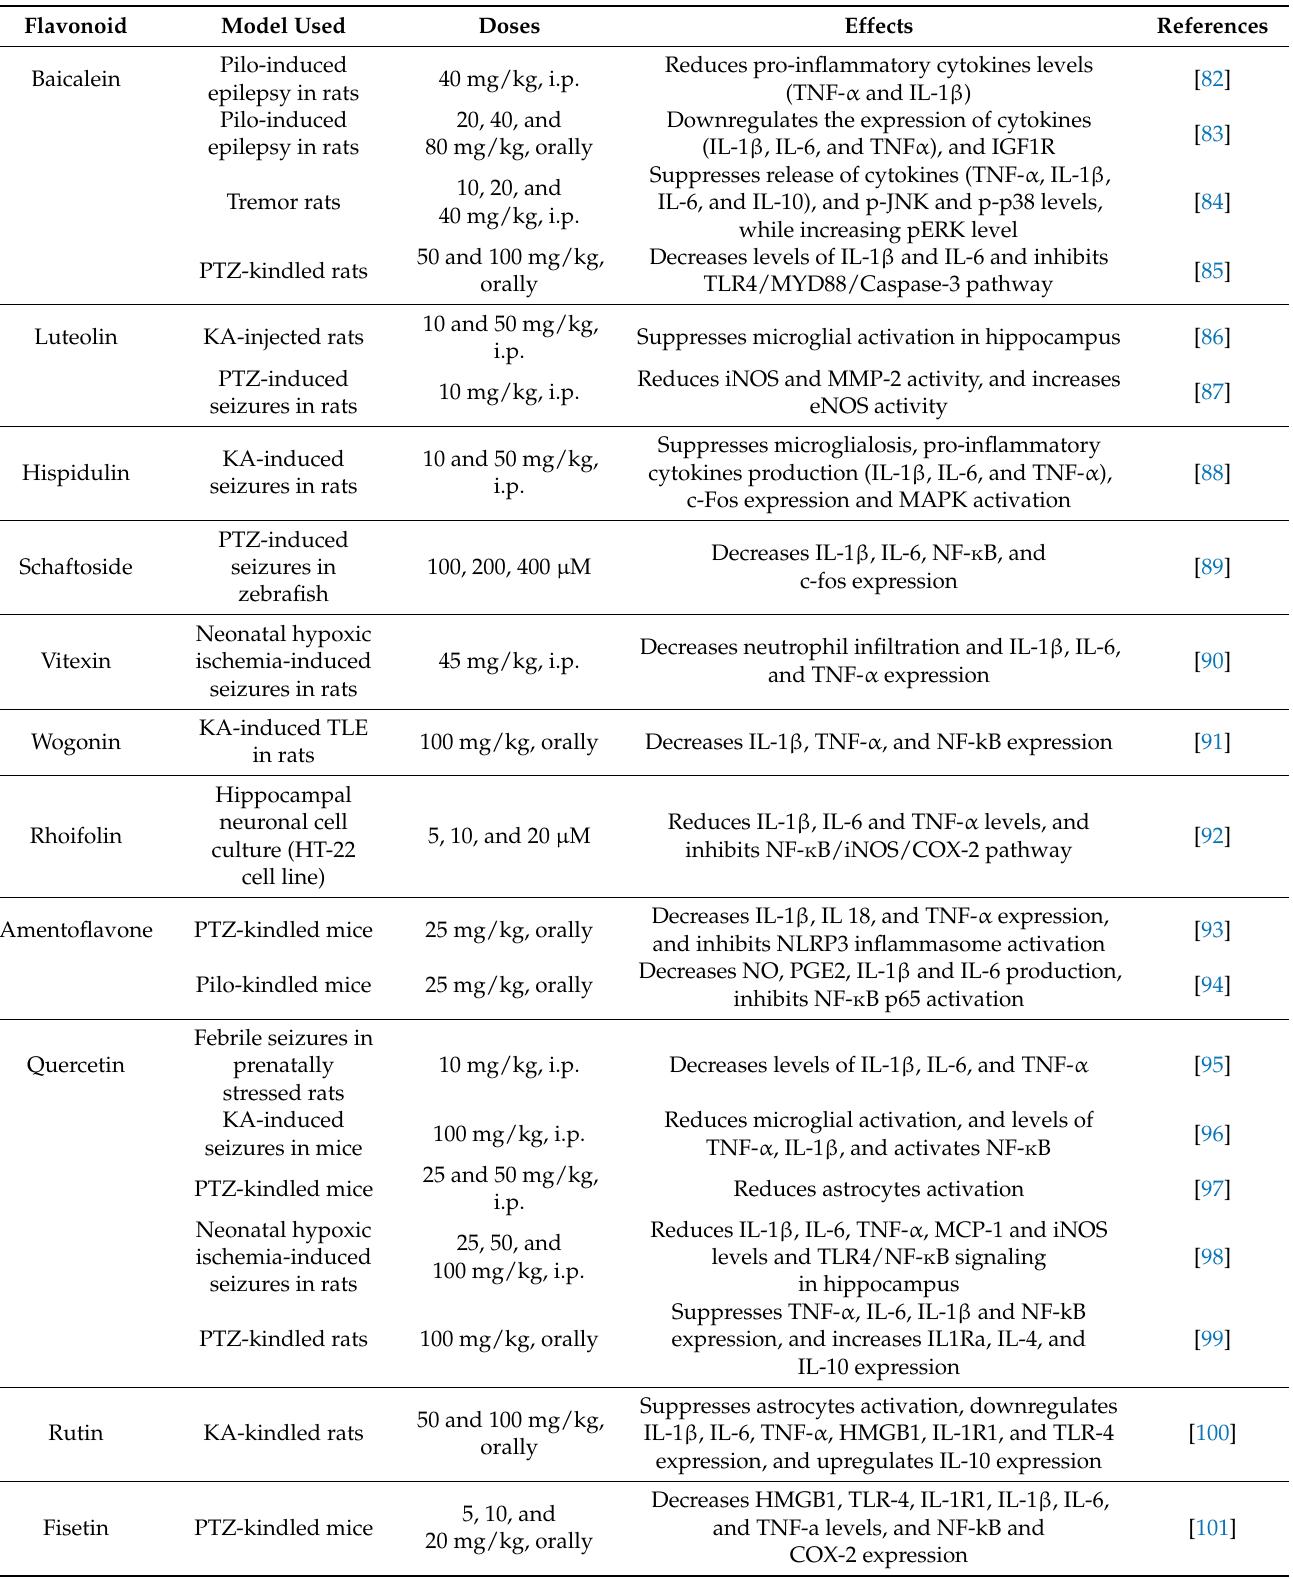
Table 1. Summary of anti-inflammatory properties of flavonoids in